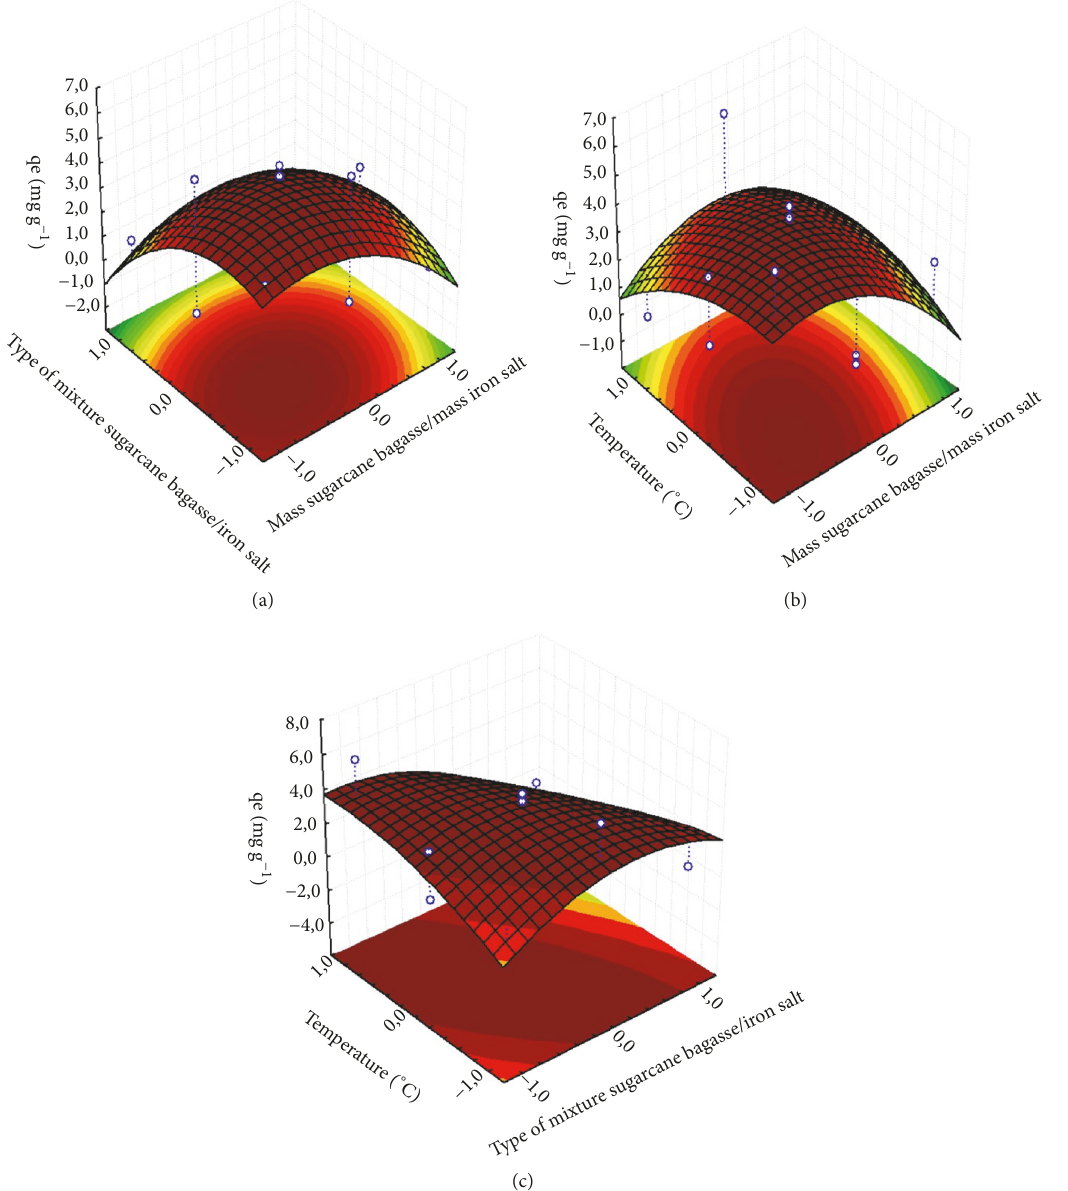
Figure 1: Response surfaces for 𝑞 𝑒 as a function of (a) mass SB/mass IS and type of mixture SB/IS, (b) mass SB/mass IS and temperature,and (c) type of mixture of SB/IS and temperature. SB: sugarcane bagasse; IS: iron salt.